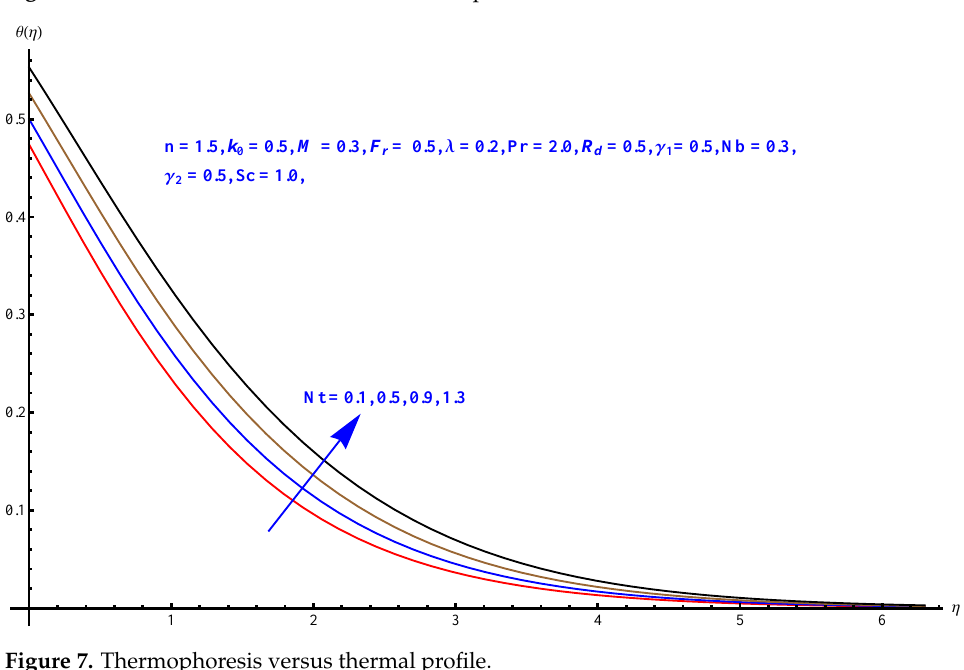
Figure 6. Thermal Biot number versus thermal profile.